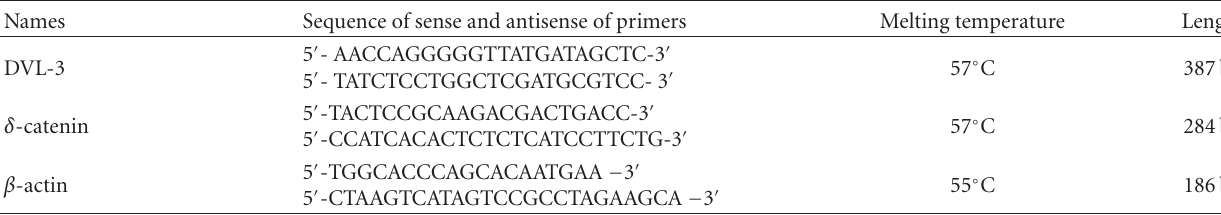
Table 1: Sequences and features of the primers used for